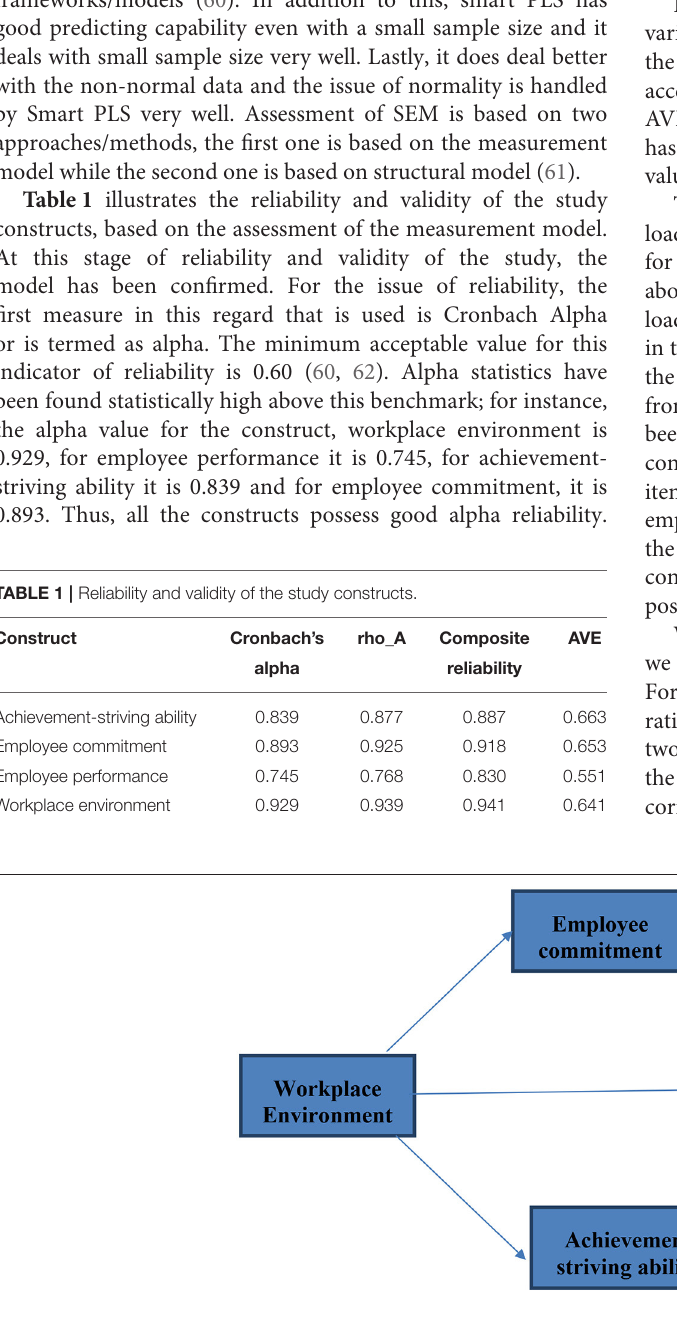
FIGURE 1 | Conceptual